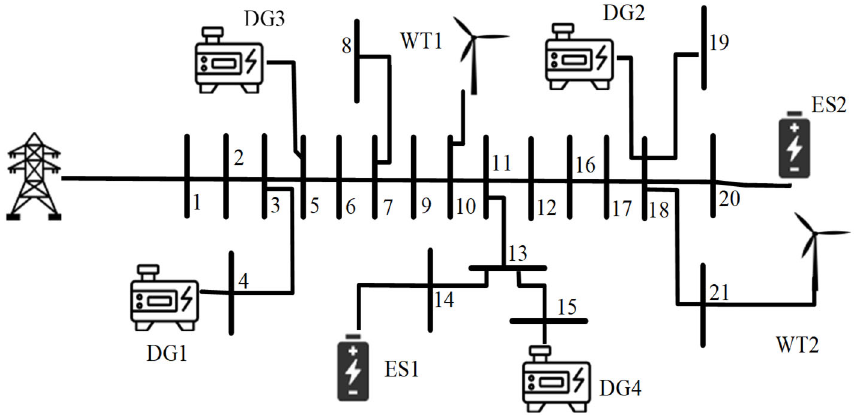
Figure 2. Overall structure of the case study.